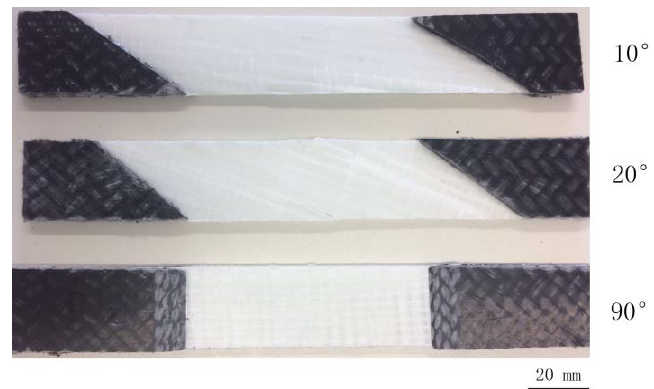
Figure 6. Macroscopic photographs of off-axis samples after the cyclic loading-unloading recovery test.